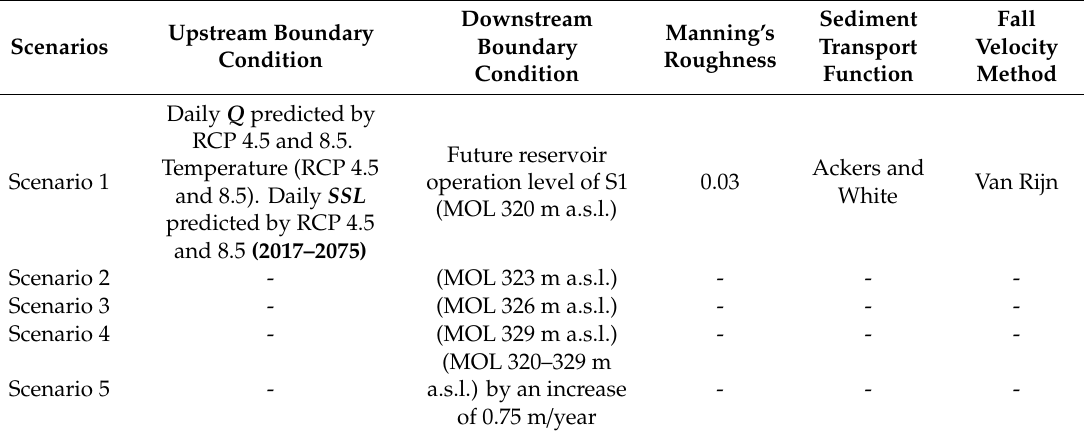
Table 4. Model boundary condition for future simulation.